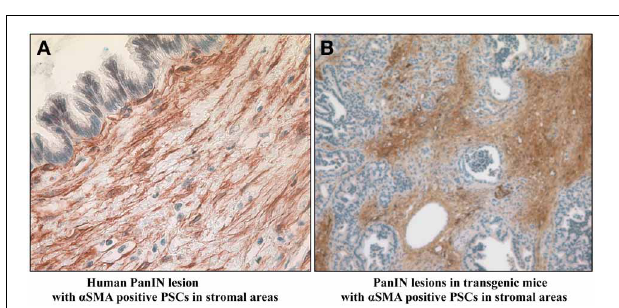
FIGURE 5 | Presence of α -smooth muscle actin positive activated pancreatic stellate cells in stroma surrounding early PanIN lesions in (A) humans and (B) transgenic mice. Reprinted with permission Apte et al.